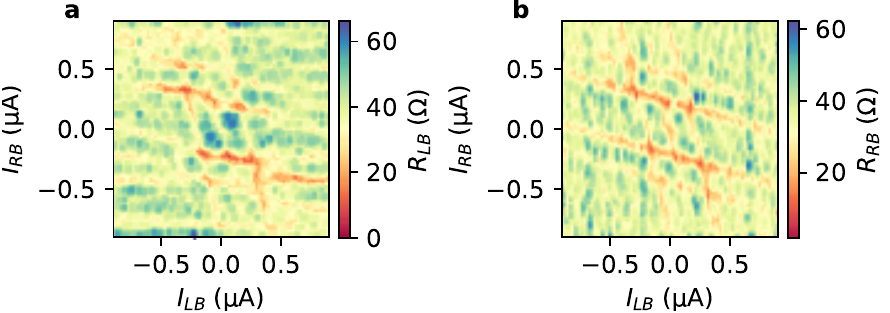
Figure 5. Shapiro step measurements at 5.8GHz: ( a ) Numerically determined differential resistance R LB as a function of I LB and I RB at 5.8GHz and rf power of 0dBm. ( b ) Corresponding map of the differential resistance R RB